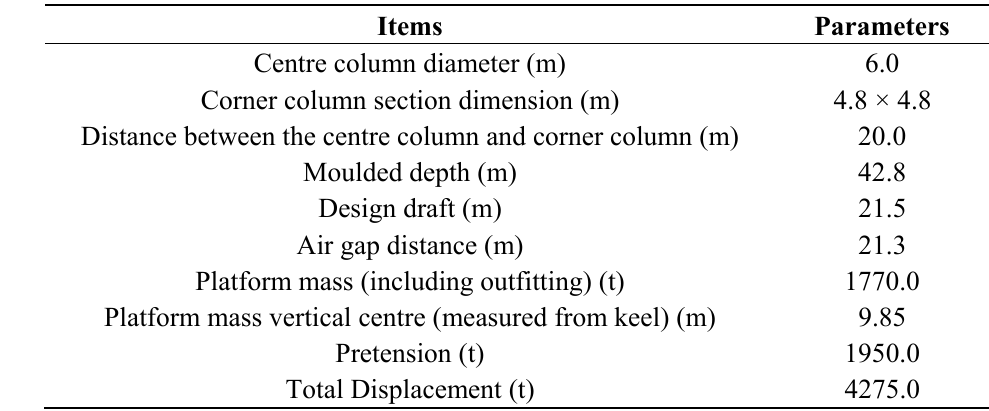
Table 4. Principal parameters of the WindStar